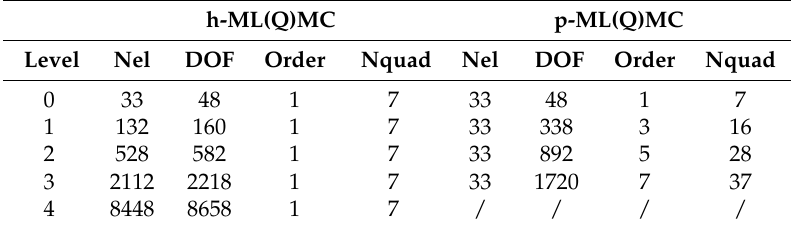
Table 2. Number of elements, degrees of freedom, element order and number of quadrature points for model problem